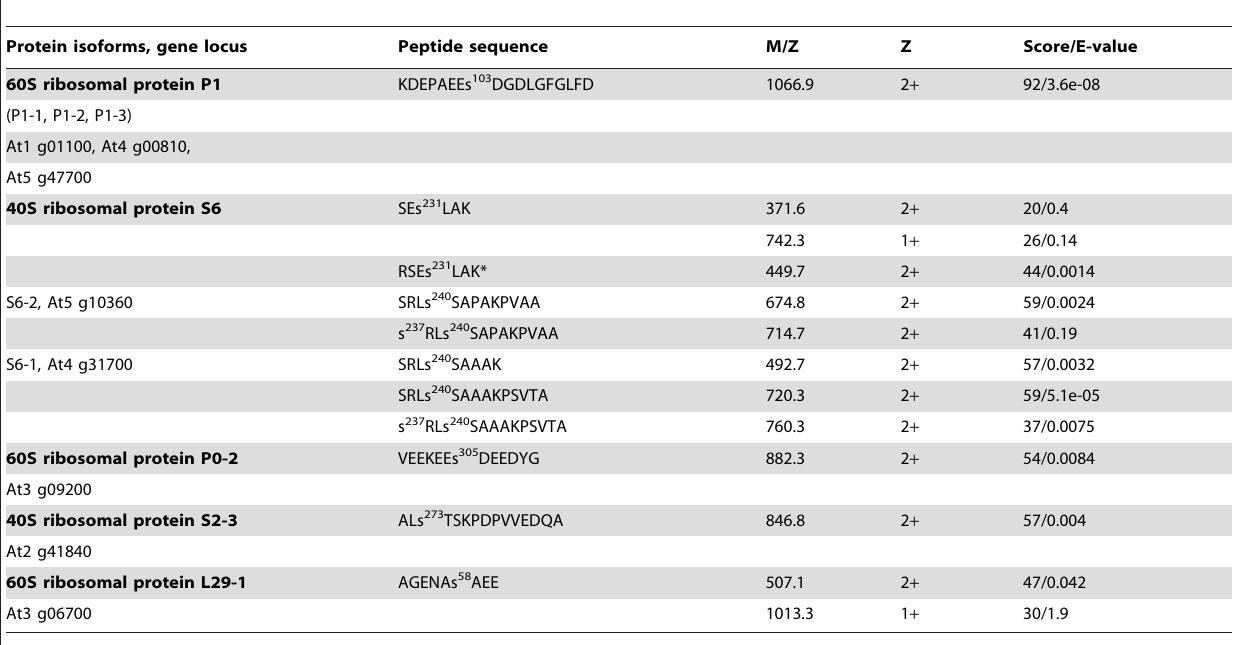
Table 1. Ribosomal phosphopeptides identified using LC-MS/MS after IMAC.